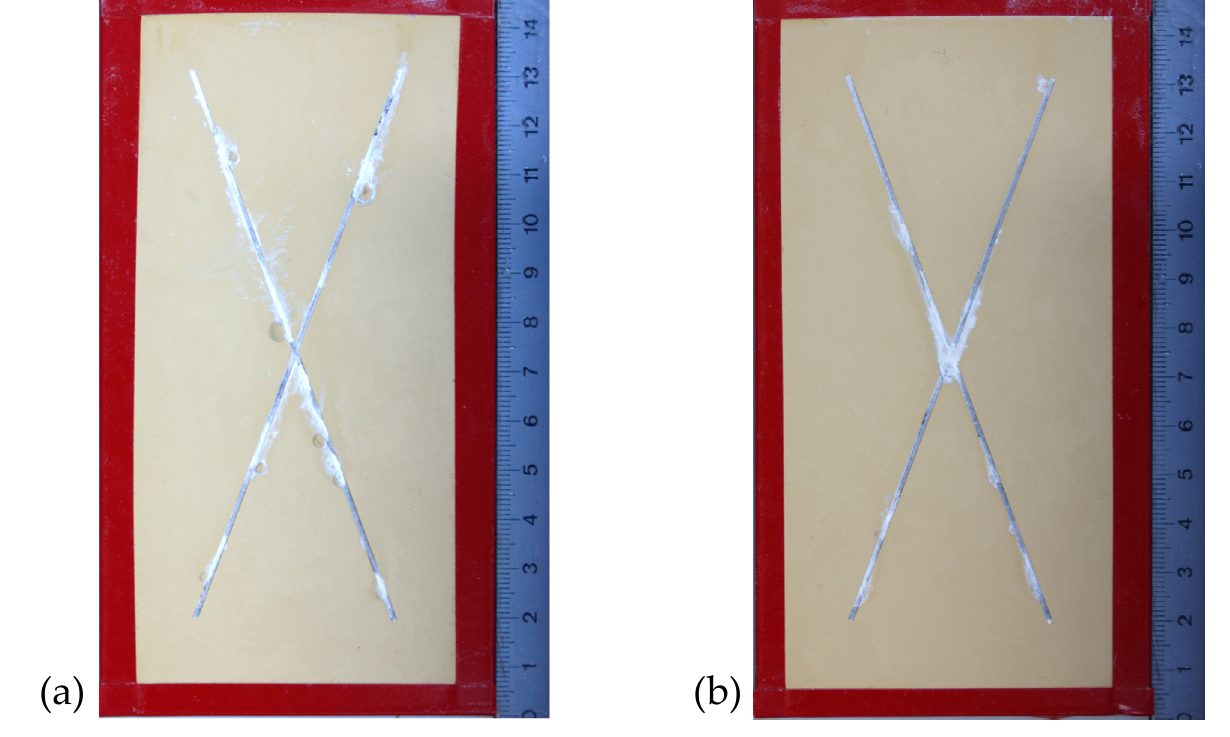
Figure 14. Visual inspection after 3000 h neutral salt spray test: ( a ) TSA 20 V 37 °C; ( b ) TSA 14 V 55 °C. Table 3. Average length of maximum paint creepage of triplicate test and standard deviation after 3000 h exposure to the neutral salt spray test.